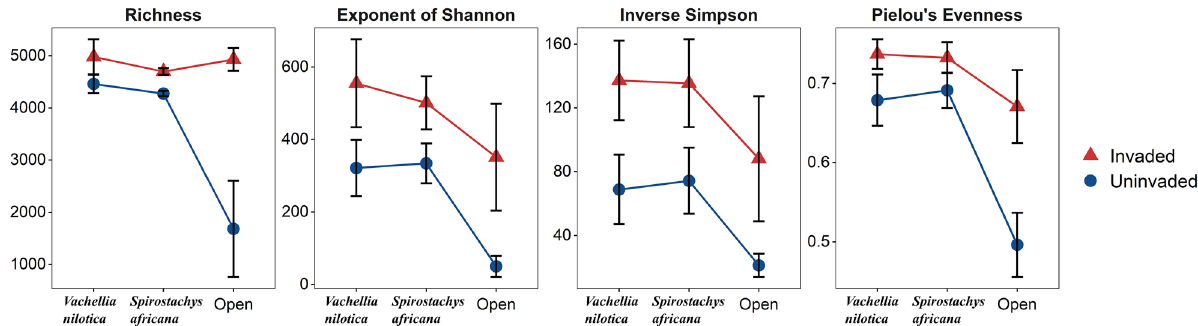
Figure 2. Diversity metrics for soil bacterial communities associated with O. stricta invasion (i.e. invaded vs. uninvaded) and tree cover (i.e. V. nilotica , S. africana , none) categories. Error bars represent the standard deviation of the mean. Factor Df Sum of squares F p Tree